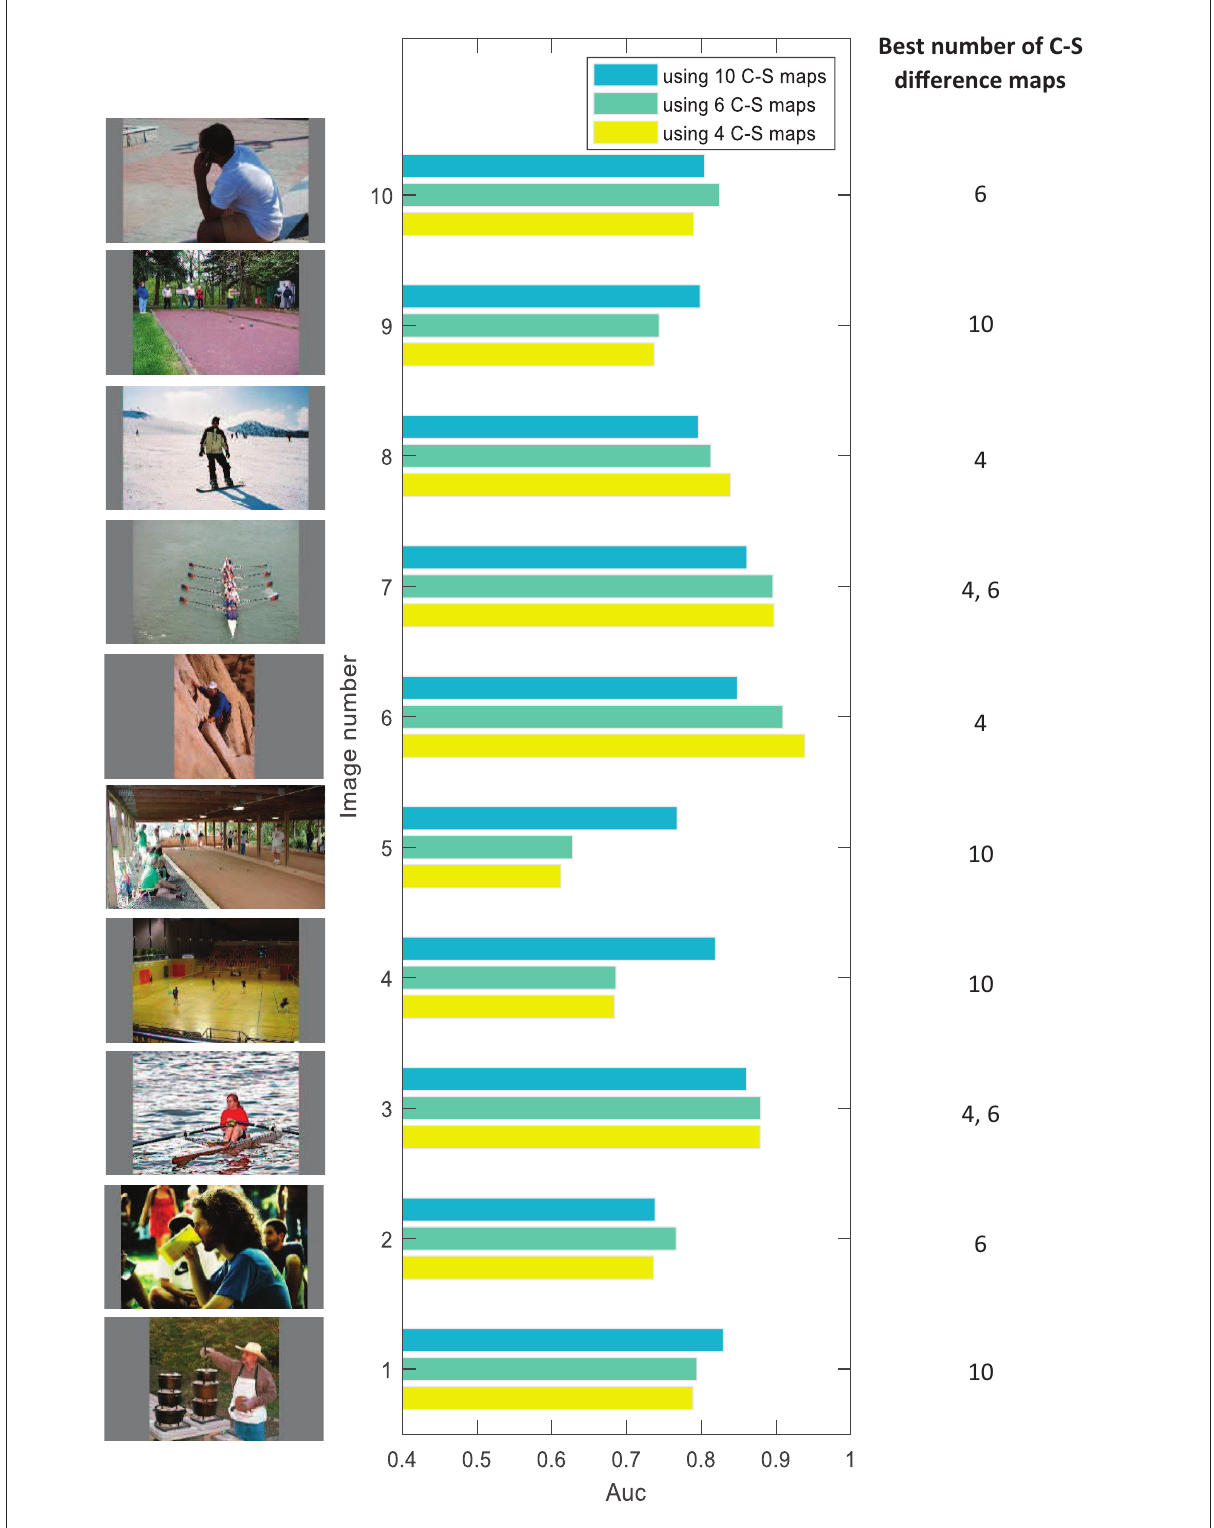
FIGURE5 Comparing the AUC results of the model between three different cases of using 4, 6, and 10 C–S difference maps for some sample images from the dataset. The results show that images with different contents require a different number of C–S difference maps to result in high performance for the